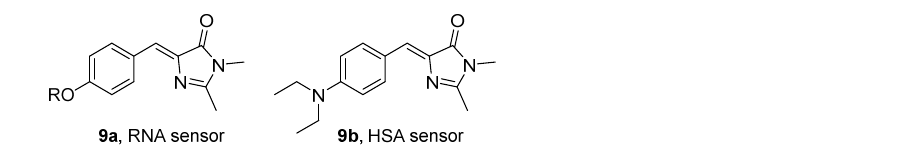
Figure 10. GFPc analogues with enhanced emission intensity in the presence of HSA [24].